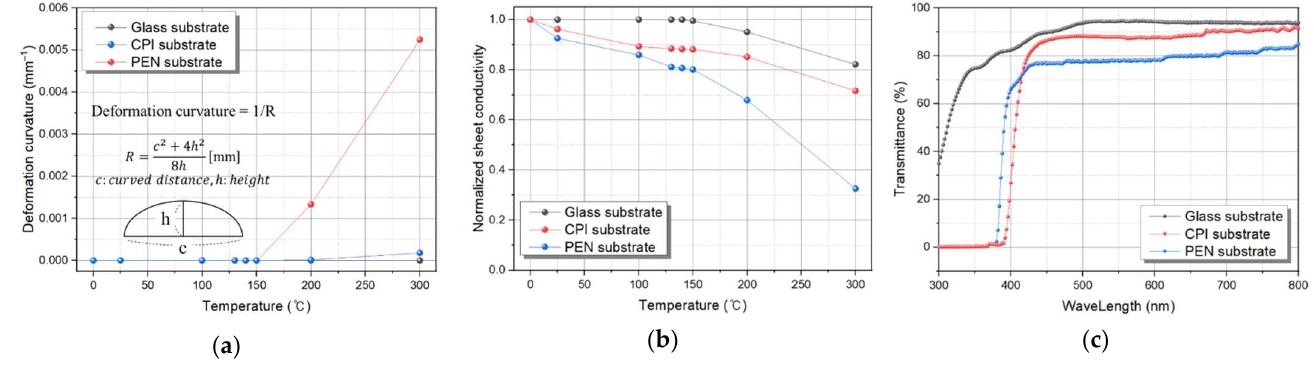
Figure 4. ( a ) Deformation curvature of glass, PEN, and CPI plastic substrate, ( b ) sheet conductivity of the substrates according to heat temperature, and ( c ) transmittance of substrates.